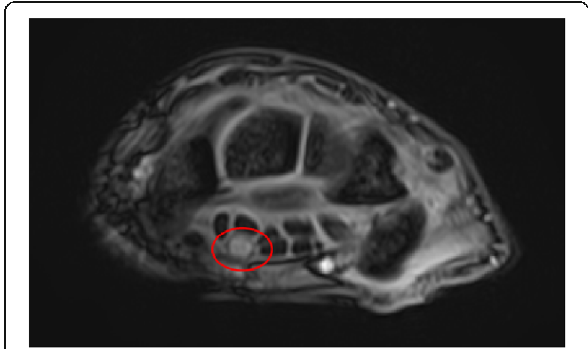
Fig. 2 Magnetic resonance imaging of the left wrist. The red circle indicates the left median nerve. Magnetic resonance imaging shows swelling of the left median nerve and no